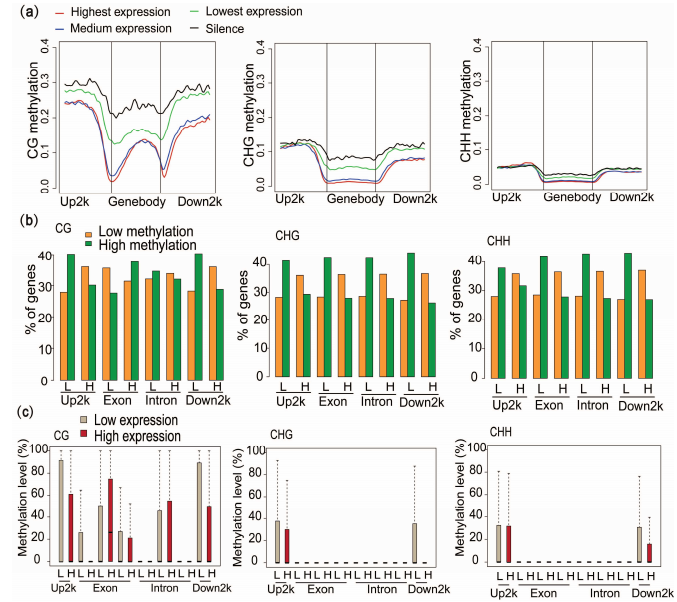
Figure 4. Methylation at various genic regions differentially associated with gene expression. ( a ) Association between methylation and gene expression levels in the CG, CHG and CHH contexts. Genes were sorted into four groups based on their gene expression levels. Highest expression: gene expression ≥10; medium expression: 1 < gene expression < 10; lowest expression: 0 < gene expression ≤ 1; silence: gene expression = 0. ( b ) Comparison of gene expression and methylation levels for mCG, mCHG and mCHH sites, and for each genic region: upstream 2-kb regions (Up2k), exons, introns and downstream 2-kb regions (Down2k). Low and high methylation represent the one-third of genes with the lowest and highest methylation levels with respect to each genic region, respectively. L and H at the bottom of the bars indicate the one-third of genes with the lowest or highest expression levels, respectively. Gene percentages were calculated separately for each L or H expression group. ( c ) Comparison of average methylation levels (%) between low and high expression genes for mCG, mCHG or mCHH sites in each genic region.